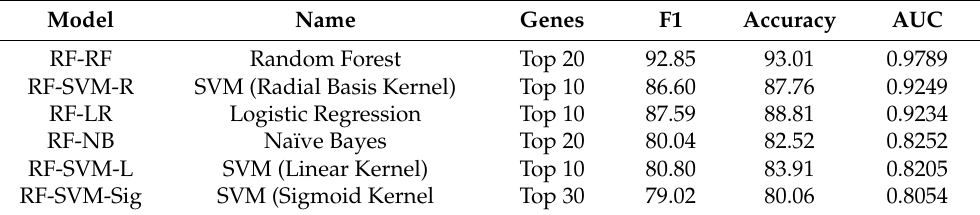
Table 4. Model performance (validation data set) using biomarkers discovered through random